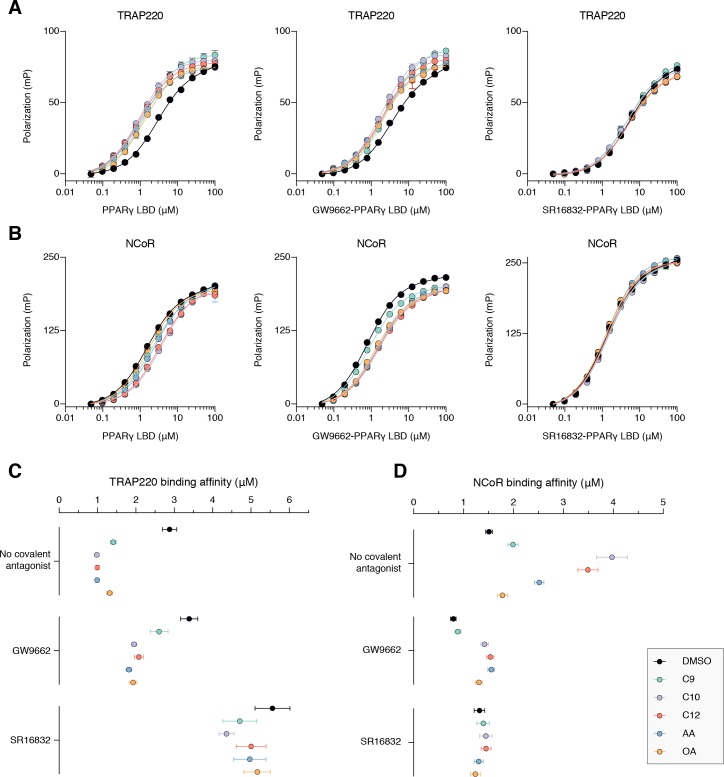
Fluorescence polarization (FP) assays performed using FITC-labeled peptides derived from (A) TRAP220 coactivator and (B) NCoR corepressor shows how coregulator affinities (C) and (D), respectively, are affected by cobinding of synthetic covalent ligands (GW9662 and SR16832) with MCFAs or UFAs.Data in (A,B) plotted as the average and S.D. of three experimental replicates; data in (C,D) show the Kd values and fitted errors for the data in (A,B) that were fitted to a one site total binding equation.